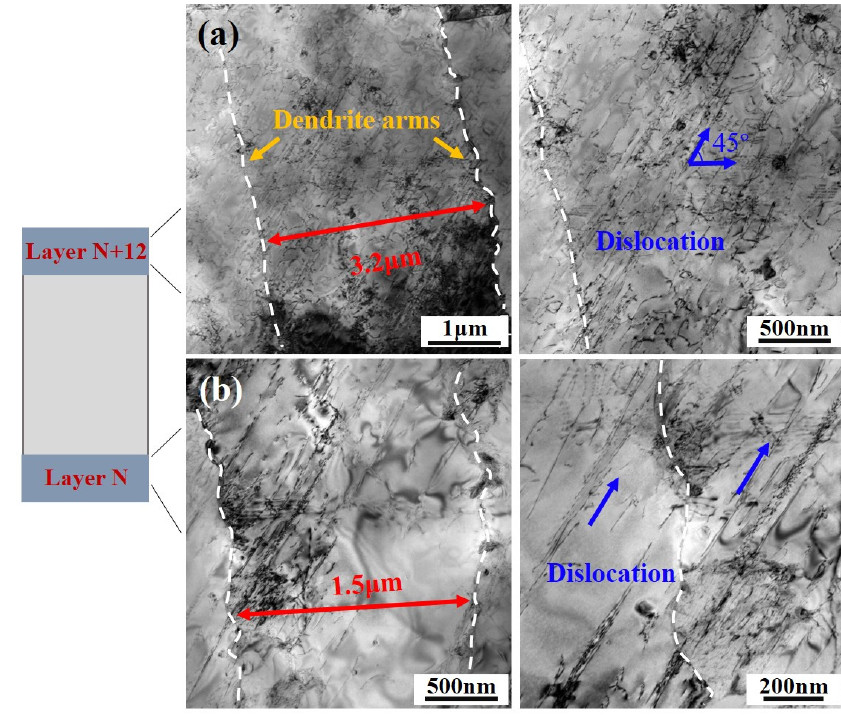
Figure 7. Dislocation distribution of ( a ) Layer N and ( b ) Layer N + 12.